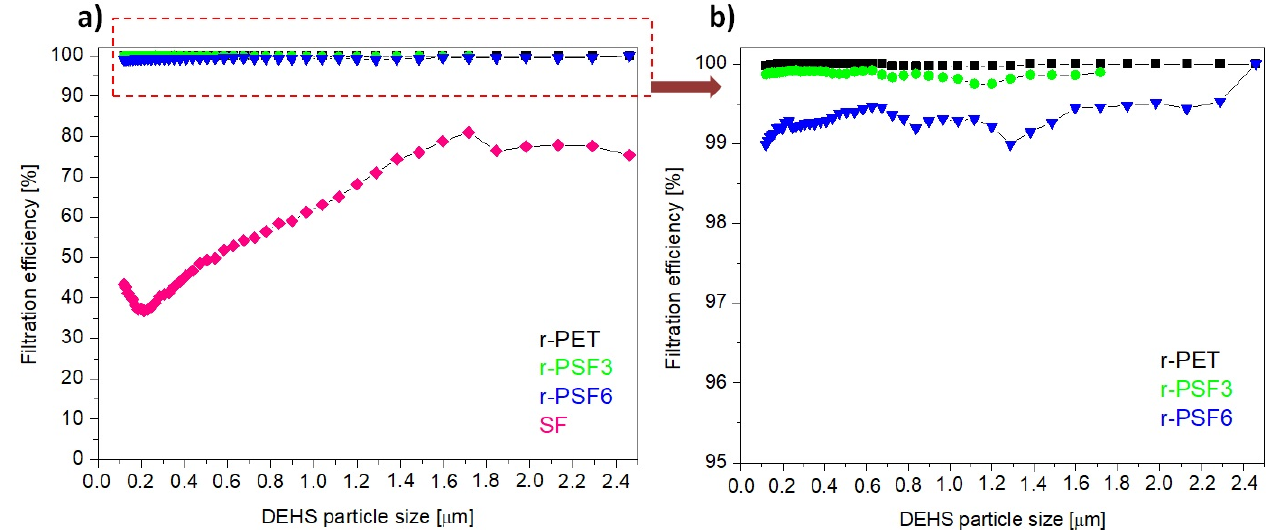
Polymers 2021 , 13 , x